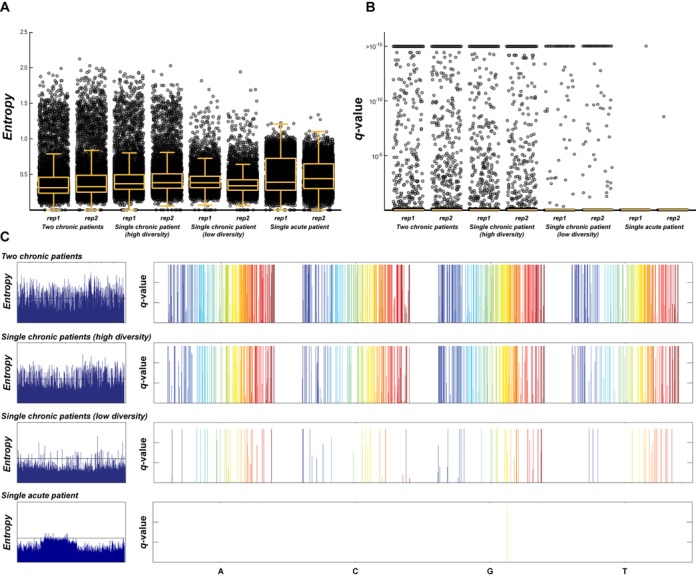
Identification of true diversity among samples with variable degrees of diversity. When the distribution of either the entropy (A) or the q-values derived from the statistical approach described (B) are compared after sequencing a mixture of two HIV-1 chronically infected patients, a single chronically infected patient with high diversity, a single chronically infected patient with low diversity, and an acutely infected patient, the probabilistic approach proves to be more sensitive to variations in real diversity. When both entropy and q-values are used to identify non-consensus nucleotides across the entire HIV-1 genome shown from 5′ (blue) to 3′ (red) (C), the differentiation between background noise and real diversity for the statistical approach versus that using entropy is apparent, allowing positions of actual diversity to be identified.